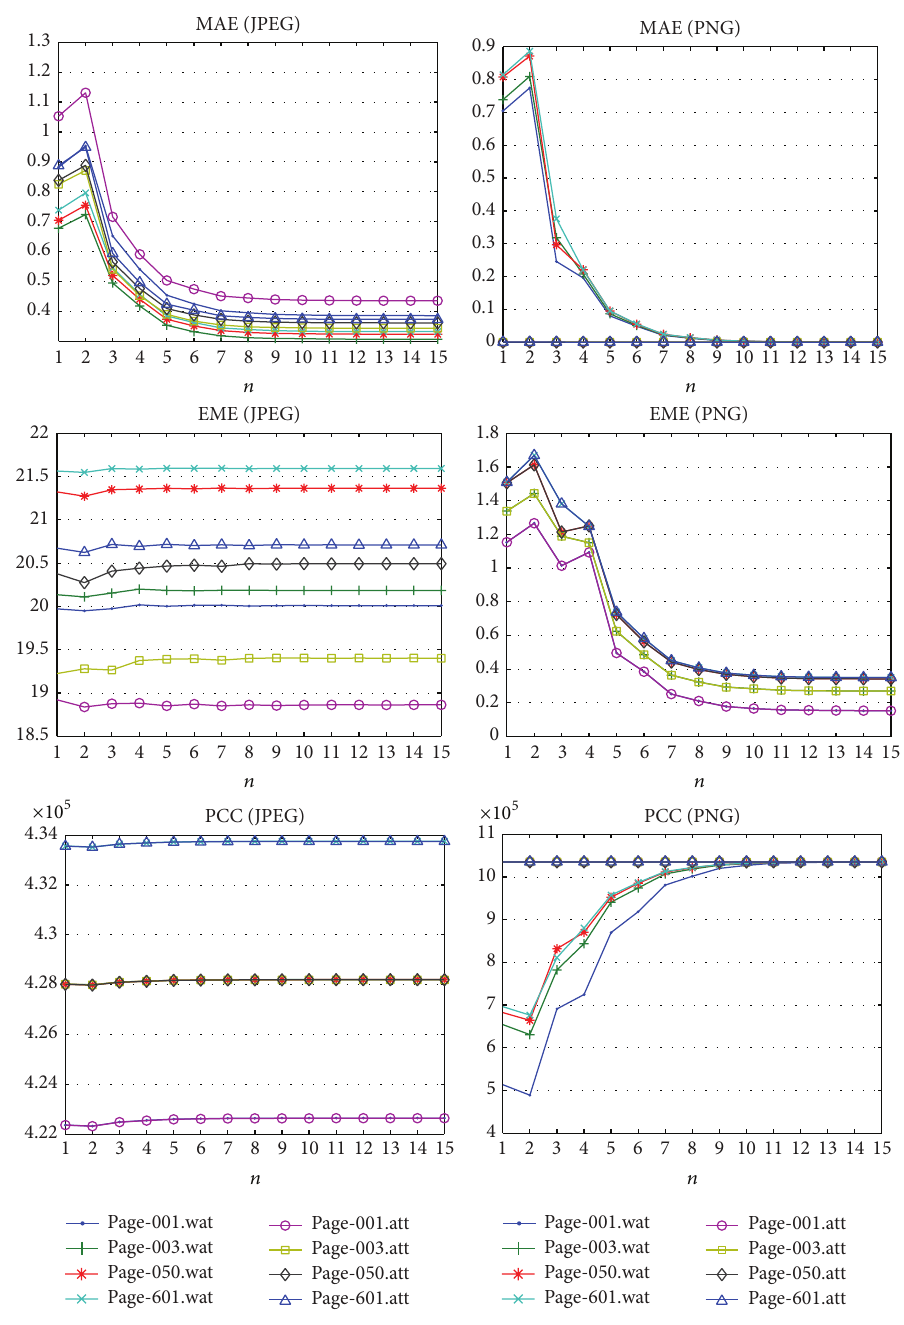
Figure 6: Image quality metrics on pixel manipulation